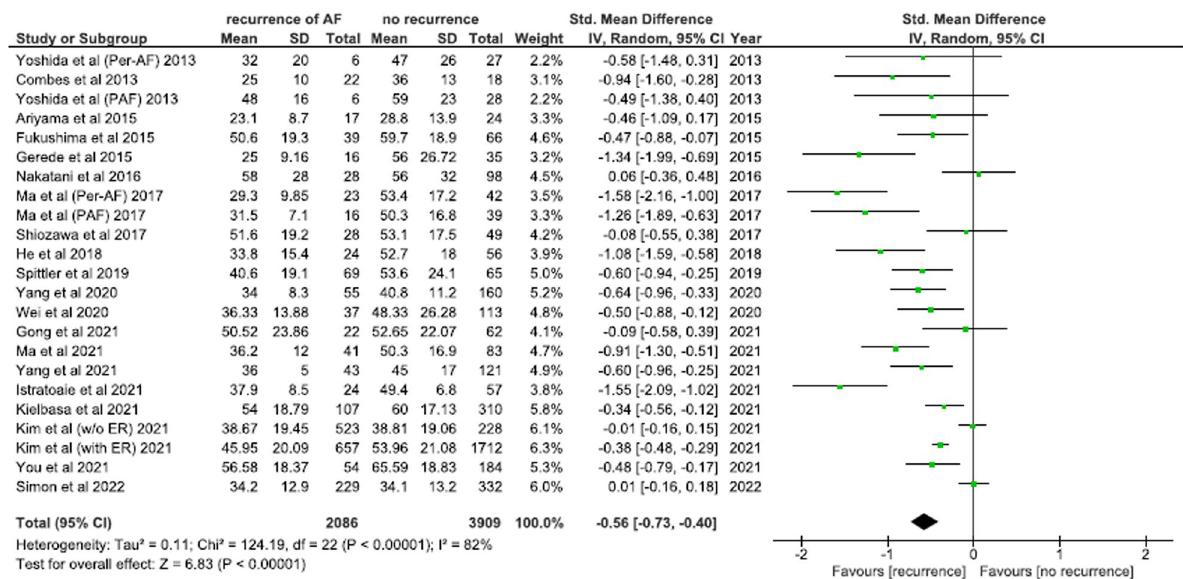
Fig. 6 Mean difference in LAA emptying velocity between arrhythmia recurrence and arrhythmia free